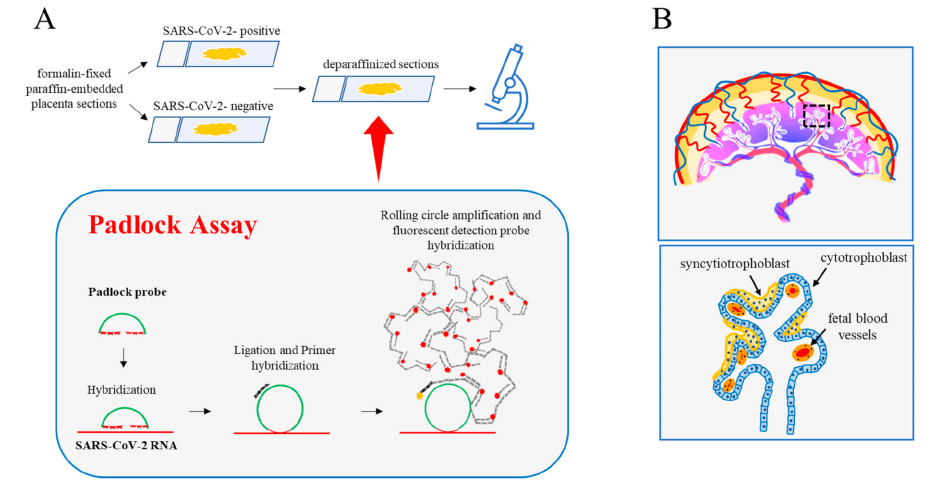
Figure 1. Padlock assay. ( A ) Diagram illustrating the main experimental steps of the padlock assay carried out in deparaffinized sections from the human placenta. Formalin-fixed paraffin-embedded sections (4 µ m thickness) from the SARS-CoV-2 positive and SARS-CoV 2-negative placentas were first deparaffinized then processed for the padlock assay. A padlock probe was designed with the 5 (cid:48) - and 3 (cid:48) -terminal bases complementary to a selected sequence of SARS-CoV-2 RNA. The padlock probe was ligated and circularized with its complementary RNA template. A short DNA primer was used for initiating rolling circle amplification (RCA). In this way, the target sequence was converted in a long DNA amplicon with several copies of the padlock probe. Finally, amplicons became detectable by hybridization with the fluorophore-labeled probe. Sections were then analyzed by a fluorescence microscope. ( B ) ( top ) A schematic model of the anatomy of human placental villi. ( bottom ) Enlarged detail illustrating the major cellular components of the villus.